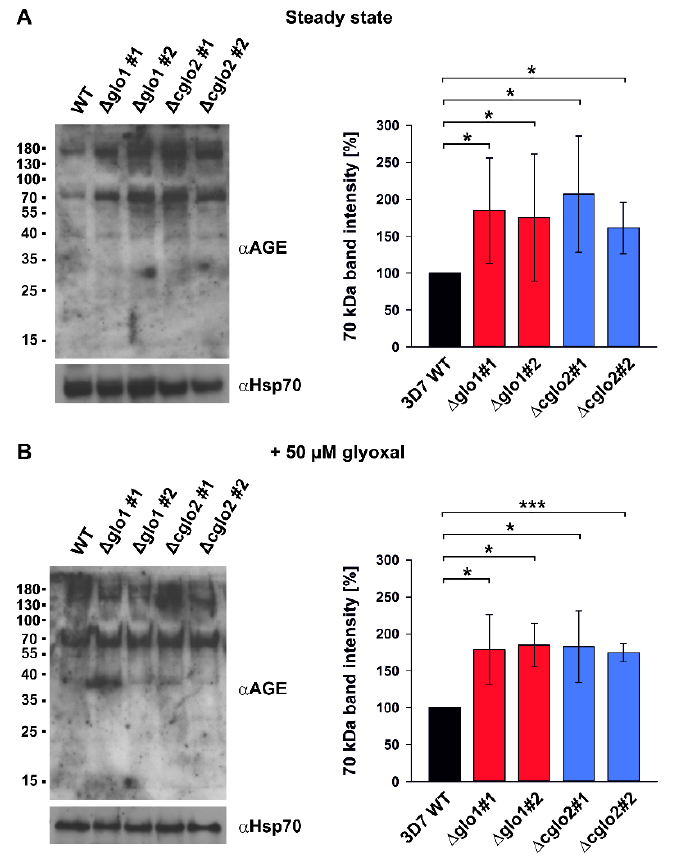
FIGURE 5: AGE detection by western blot analysis of parasite extracts from P. fal- ciparum knockout strains 3D7Δglo1 and 3D7Δcglo2 after erythrocyte removal by saponin lysis. Wild-type parasites